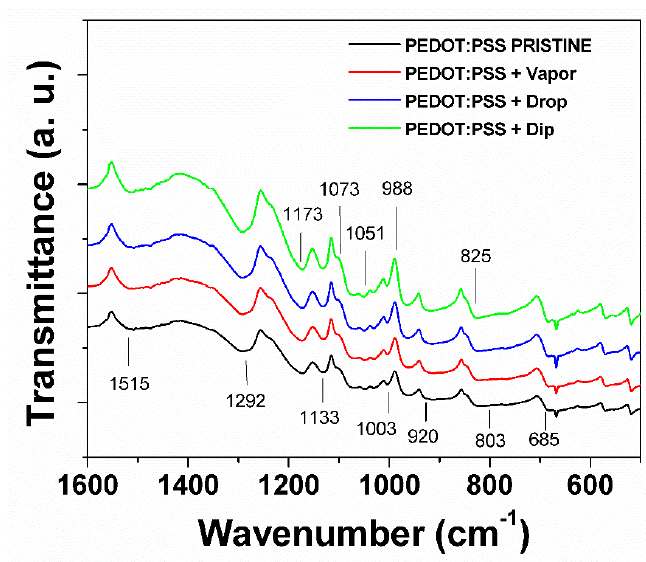
Figure 8. Fourier-transform infrared spectroscopy (FTIR) spectra of pristine PEDOT:PSS film post-treated IPA PEDOT:PSS films using VAPOR, DROP, and DIP techniques.